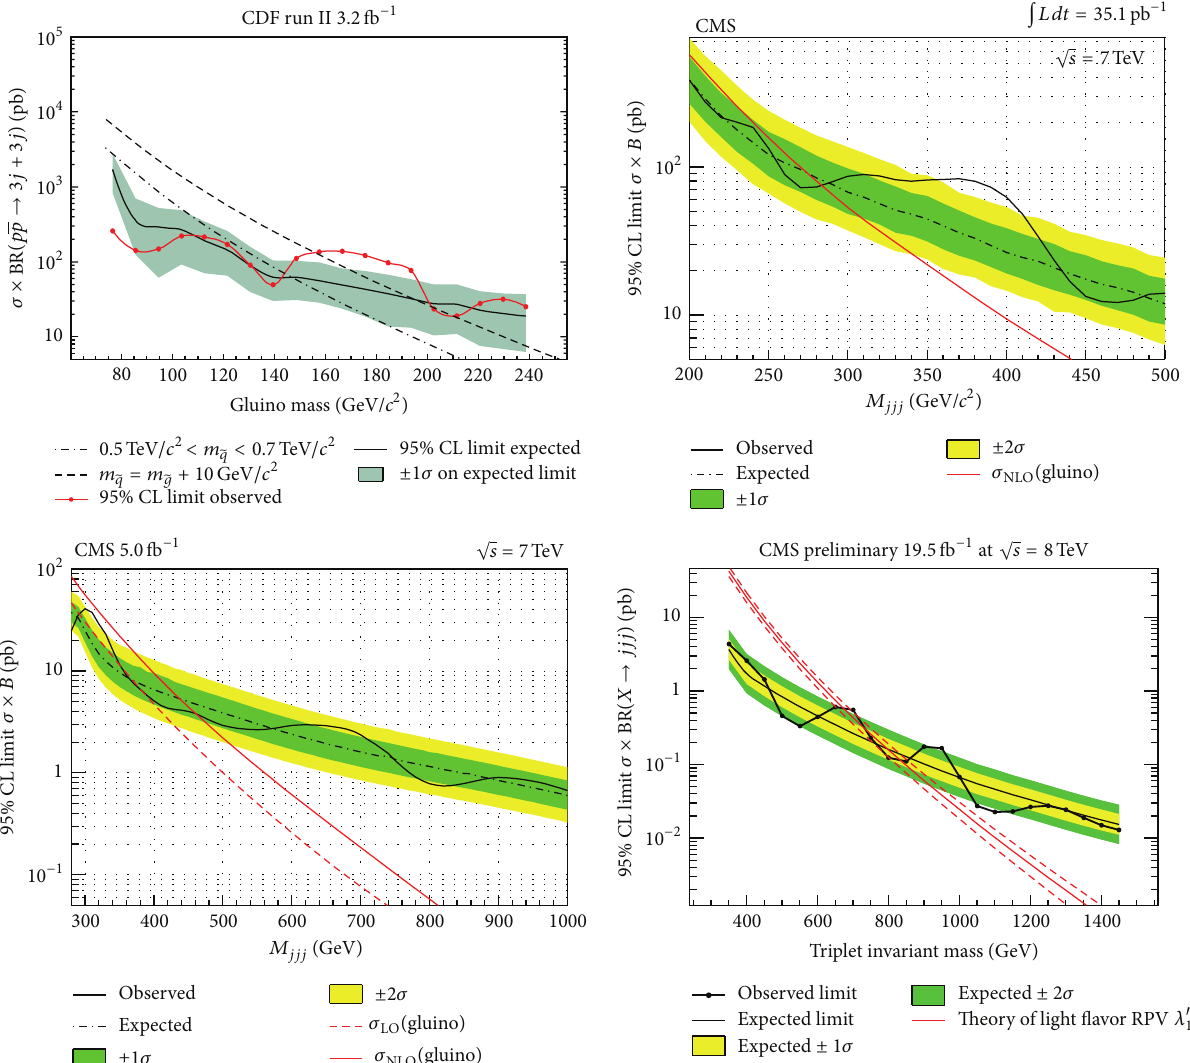
Figure 4: Limits on the gluino RPV simplified model for the resolved jet final state [7–10]. Color codes are the same as in Figure